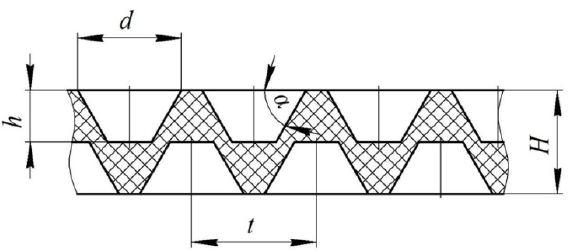
Figure 4. Characteristic dimensions of the area formed by plates with conical